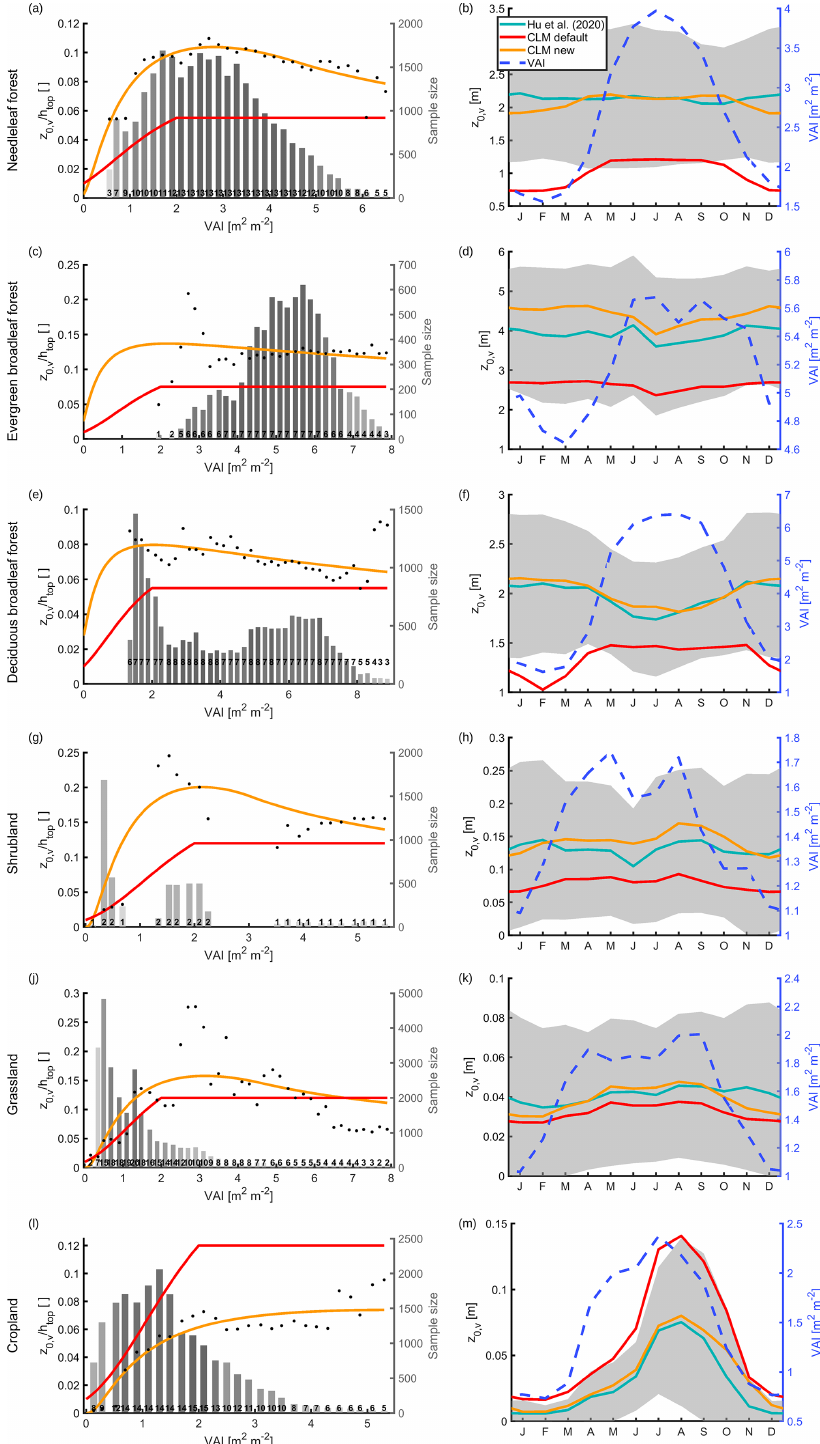
Figure 1. Left column: median z 0 , v /h top of Hu20 in VAI bins as black dots, red line the default z 0 , v parameterization of CLM, and orange line the optimized Ra92 parameterization. Height of gray bars shows the sample size in the respective bin and numbers at the bottom of the bars the number of sites that contributed to the respective bin. The darkness of the bars increases with an increasing fraction of total sites that are present in respective bin. Right column: monthly mean z 0 , v in Hu20 (turquoise), with default parameterization of CLM (red) and with optimized Ra92 parameterization (orange). Gray shading shows mean of Hu20 ± 1 standard deviation and dotted blue line mean seasonal cycle of VAI. Note that the data of sites south of 30 ◦ S were shifted by 6 months. (a–b) Needleleaf forests, (c–d) evergreen broadleaf